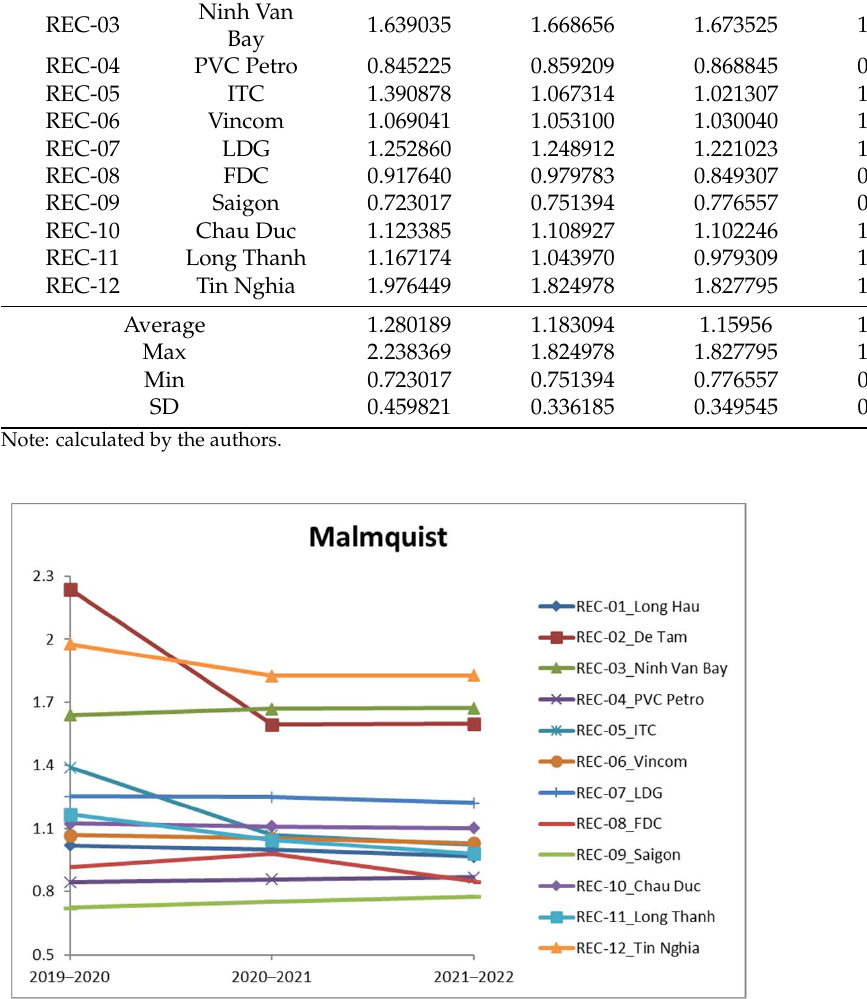
Figure 10. The comparison of total factor productivity change.